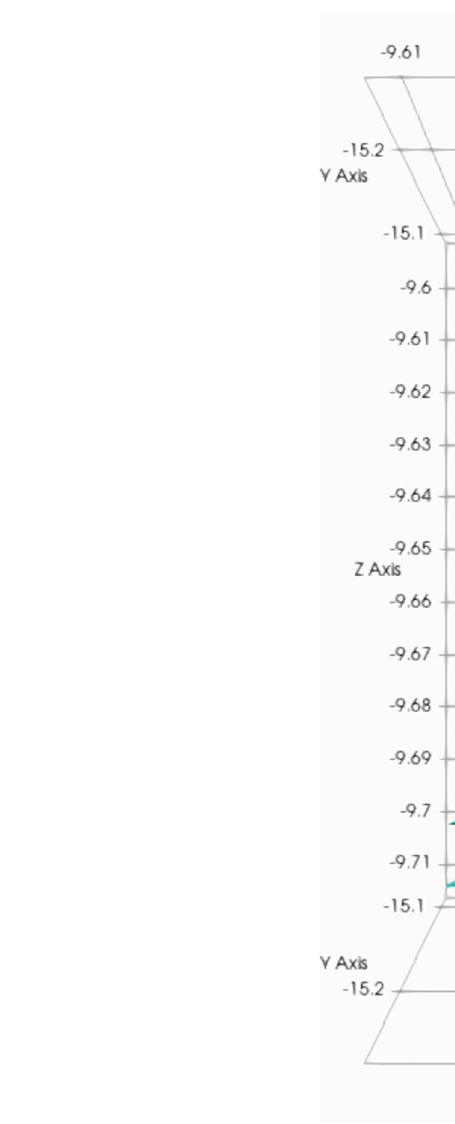
Frontiers in Physics |